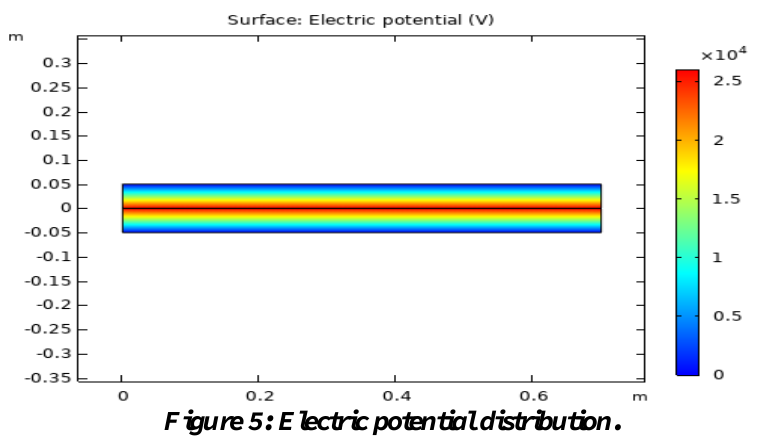
Figure 5: Electric potential distribution.